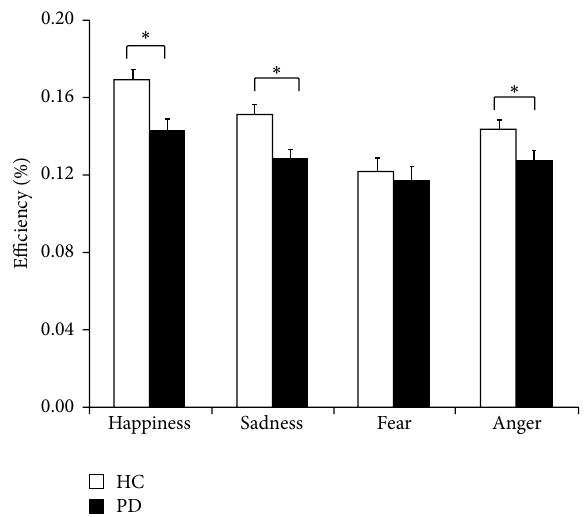
Figure 1: Mean Efficiency scores of the healthy controls (HC) and PD patients (PD) on the Fast Emotion Discrimination Task. Asterisks ( ∗ ) indicate statistical significance at 𝑝 < 0.05